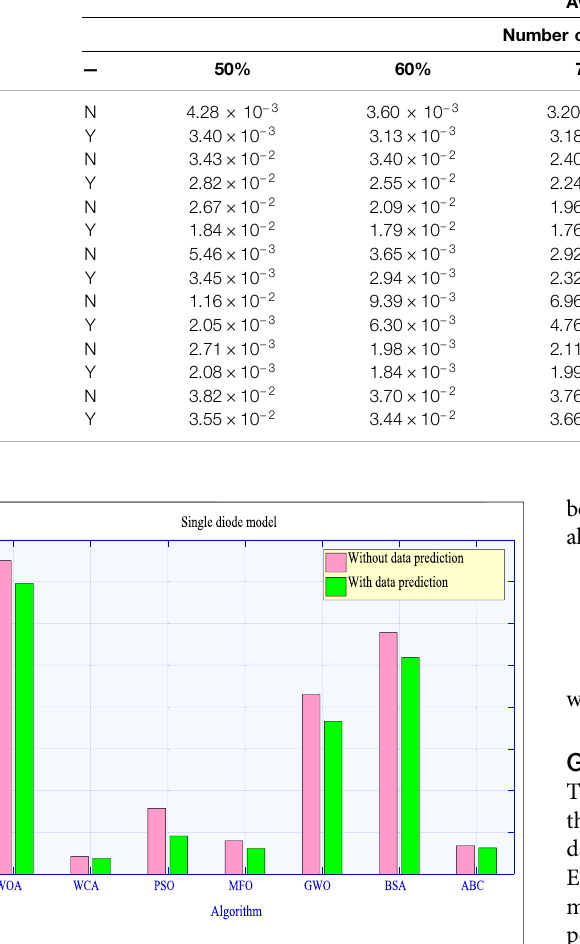
FIGURE 3 | Comparison of total average RMSE values with six different datasets for the